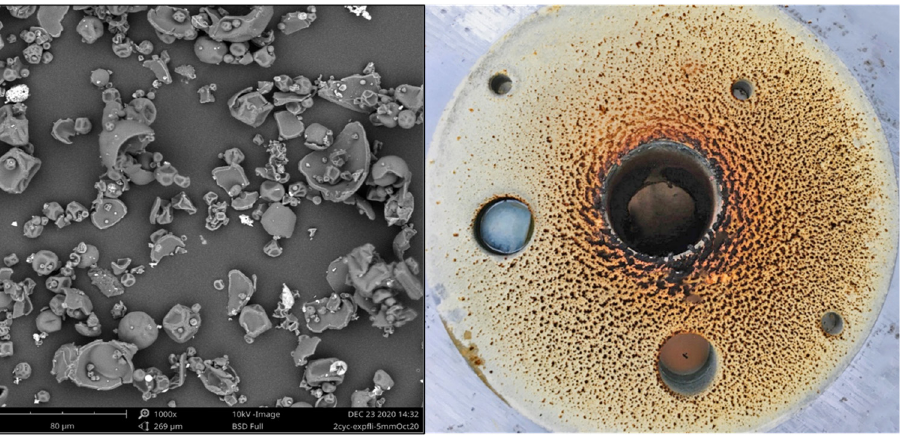
Figure 5. SEM image of recovered powdered sample ( left ), skim milk powder deposition on the bottom wall ( right ).